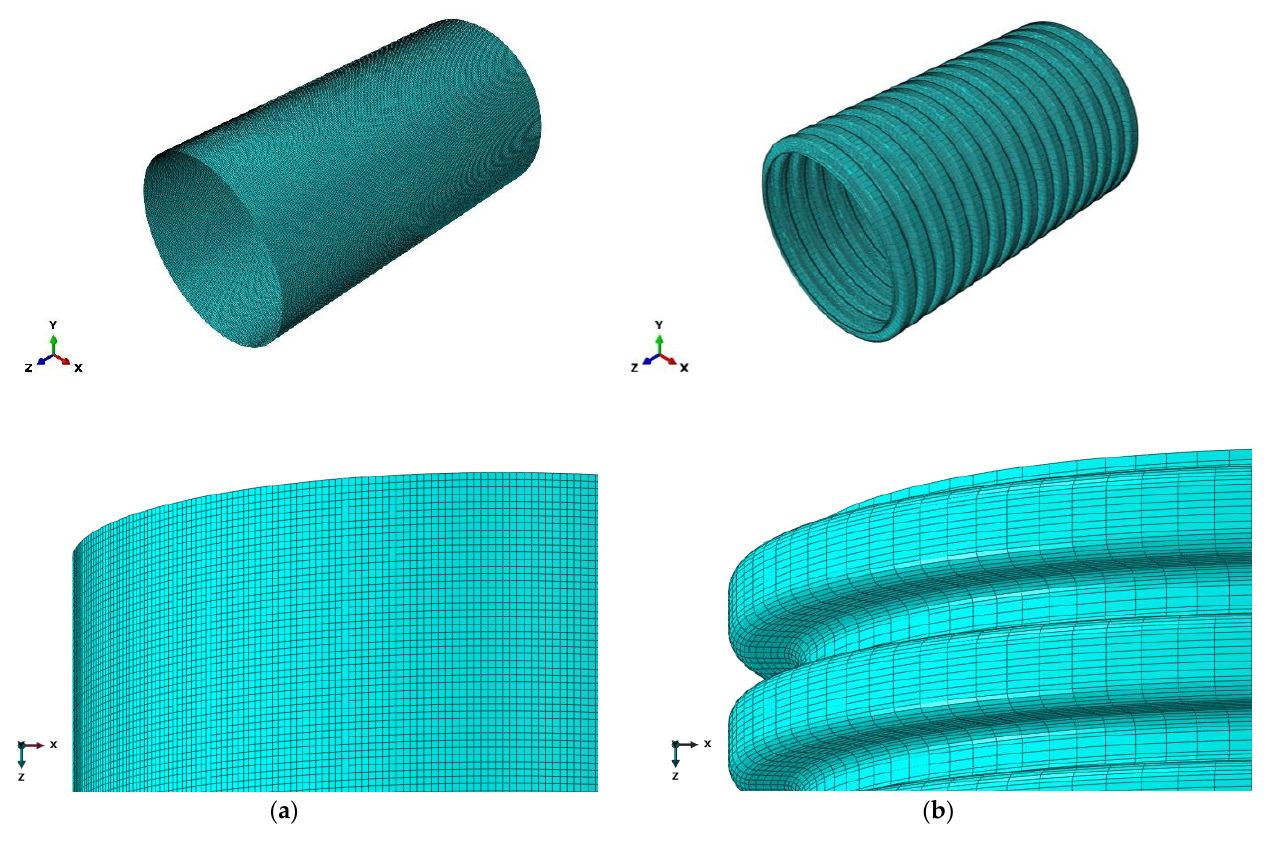
Figure 5. Elements of pipes. ( a ) Interior walls; ( b ) Exterior walls.